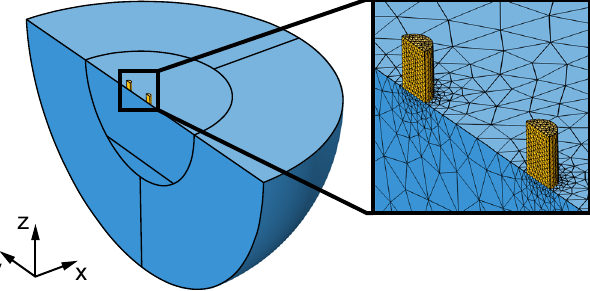
Fig. 2 Geometry and mesh of the fi nite element method simulations of two pillar resonators. The pillar pair is shown for a separation distance of d = λ SAW /2 with λ SAW = c SAW / f 0 . The pillars, whose material properties are similar to SU-8 resist, are coloured in yellow and the substrate, whose material is 127.86 ∘ Y-cut lithium niobate, is illustrated in